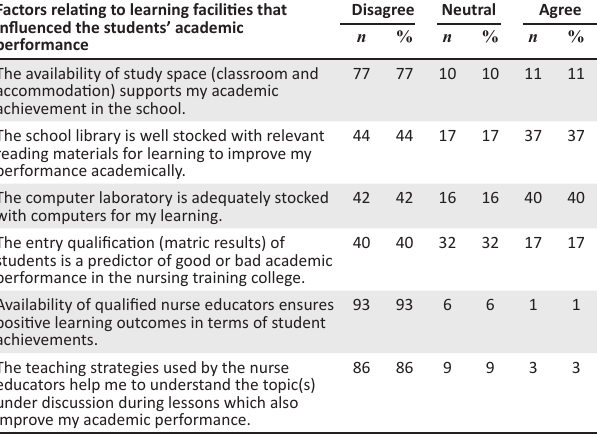
Disagree Neutral Agree n % n % n %